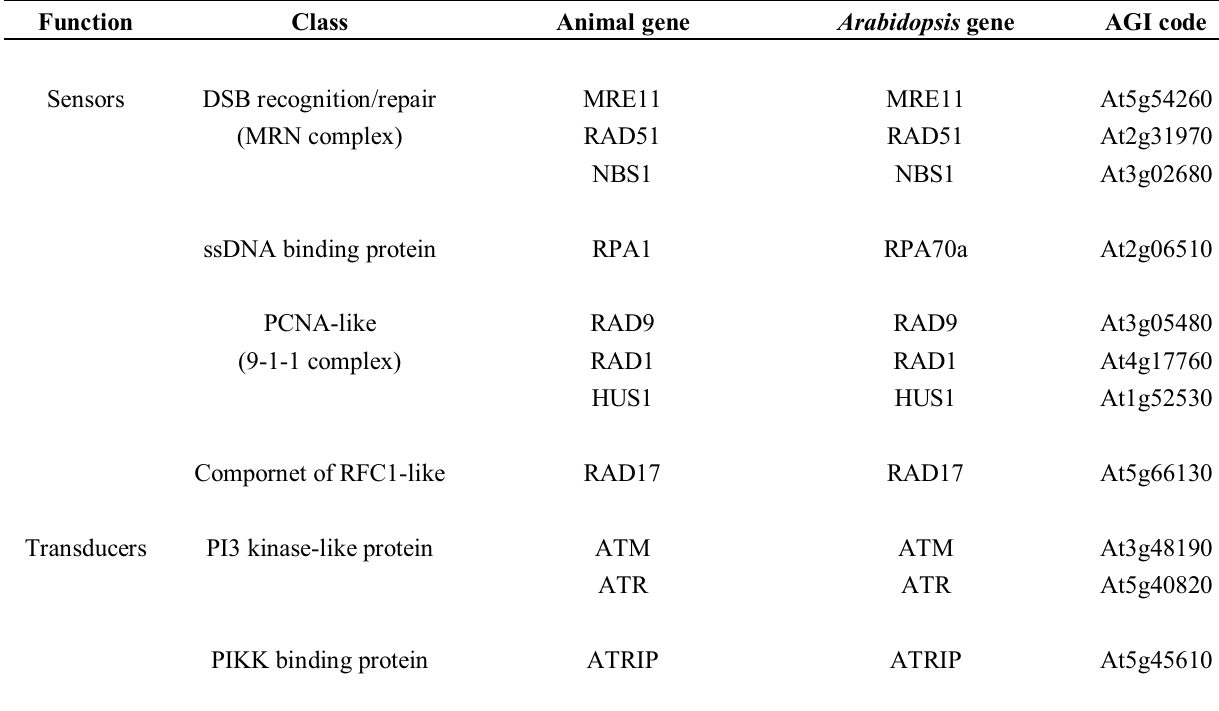
Table 1. Factors involved in DNA damage response in animals and